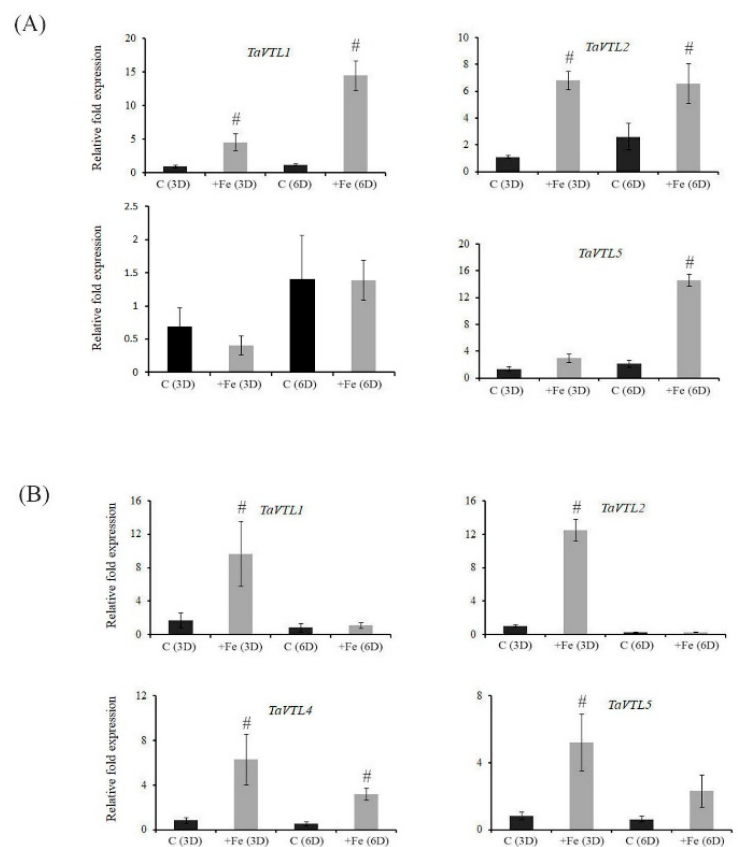
Figure 5. Tissue-specific qRT-PCR expression analysis of wheat VTL genes during Fe surplus ( + Fe) and in the control (C) conditions. Wheat seedlings were subjected to Fe surplus for three and six days represented as + Fe(3D) and + Fe(6D). The controls for the respective time points are represented as C(3D) and C(6D). ( A ) Fold expression analysis was performed in roots and ( B ) in shoots. 2 µ g of total RNA for the cDNA preparation and relative fold expression levels were calculated relative to C(3D). C t values were normalized using wheat ARF1 as an internal control. Vertical bars represent the standard deviation. # represents the significant di ff erence at p < 0.05 with respect to their respective control treatments.